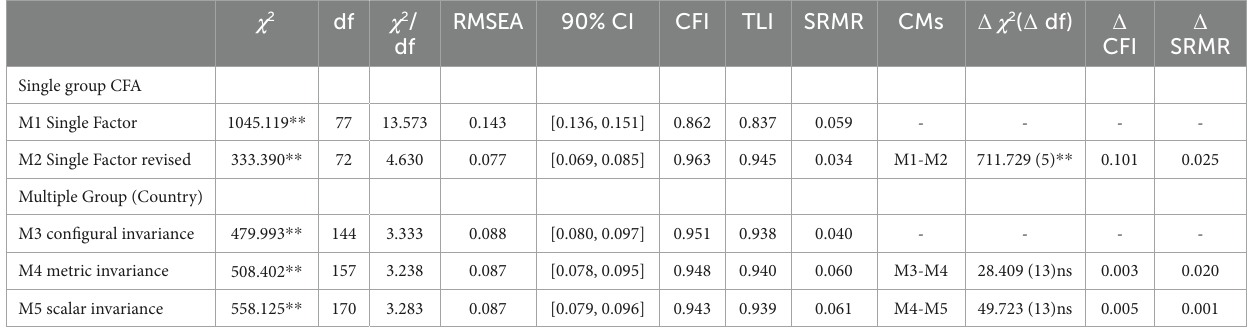
TABLE 3 Fit indexes for single group and multi-group confirmatory factor analyzes for the strength use scale (Study 1). χ 2 df